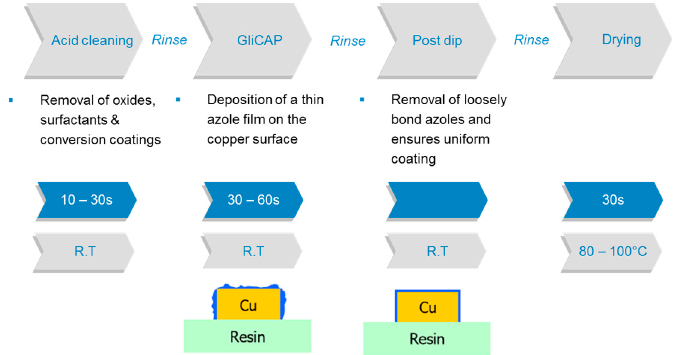
Figure 8 . Process steps for the deposition of a thin azole silane film on copper. Figure 8. Process steps for the deposition of a thin azole silane film on copper.